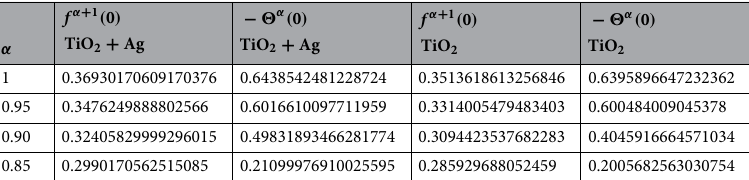
Table 1. The fraction and integer order representation of the drag force and heat transfer coefficient. When M = Ec = Ec = (cid:31) = 0.1, φ 1 = φ 2 = 0.02, Pr = 21.